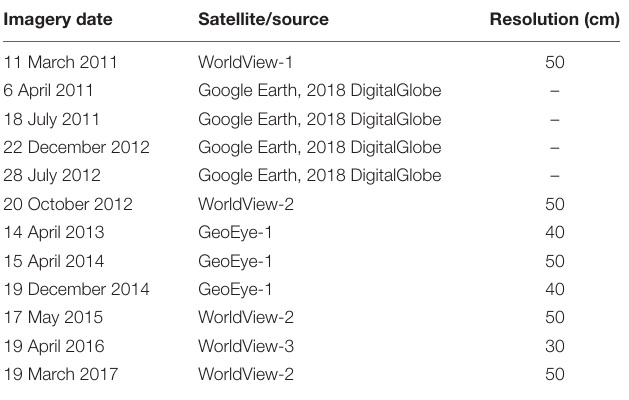
TABLE 3 | A list of satellite data used in this